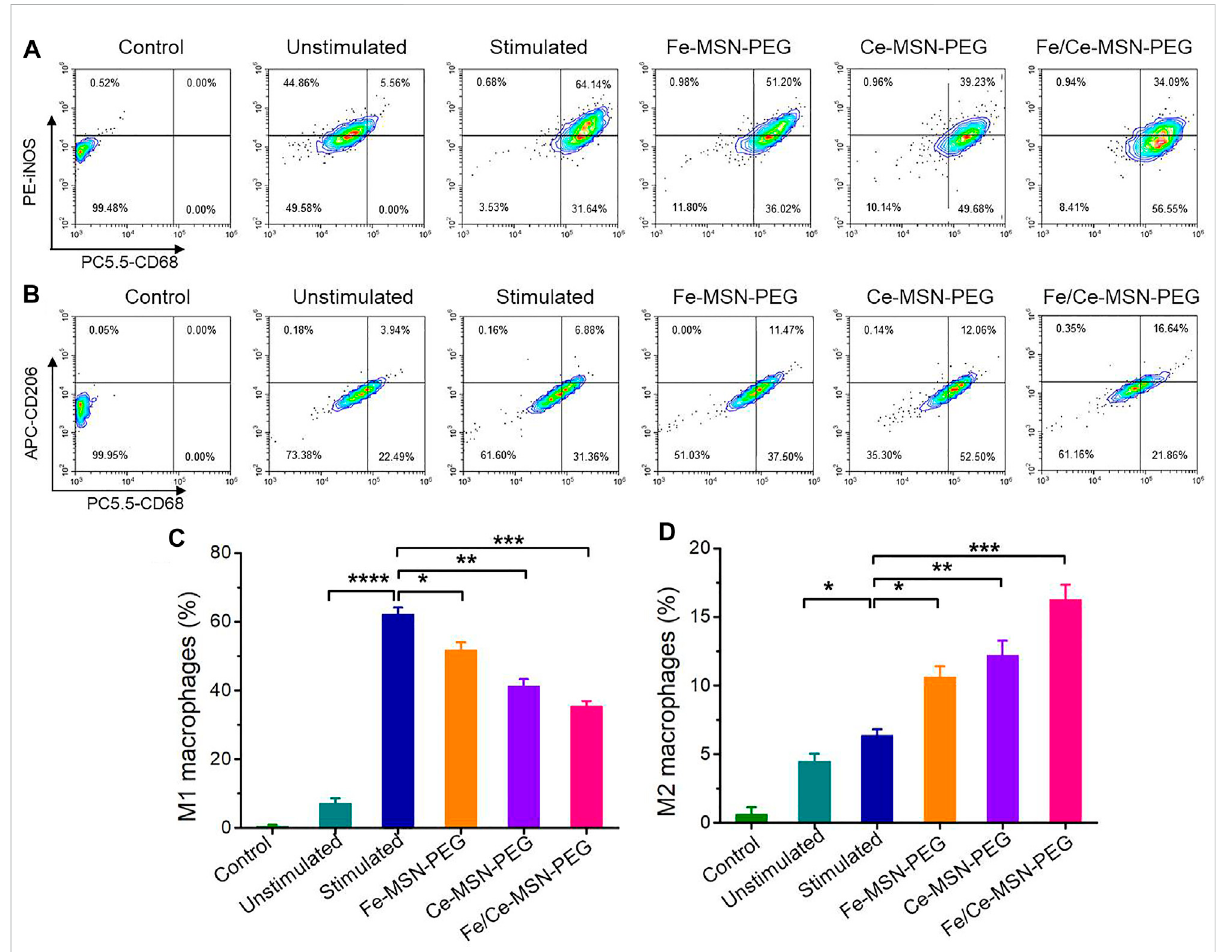
FIGURE 7 Fe/Ce-MSN-PEG NPs regulates phenotypic switching of macrophages in vitro . RAW264.7 macrophages were stimulated with 200 ng ml − 1 LPS for24 h,andthentreatedwithvariousformulationsfor8 h.Flowcytometricanalysisillustratingthenumberof (A,C) M1(CD68+iNOS+)and (B,D) M2 (CD68 + CD206+) macrophages. Data are presented as mean ± SE ( n = 3). * p < 0.05, ** p < 0.01, *** p <